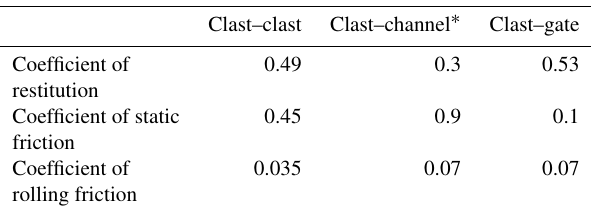
Table 3. Values of properties governing clast–clast, clast–channel and clast–gate